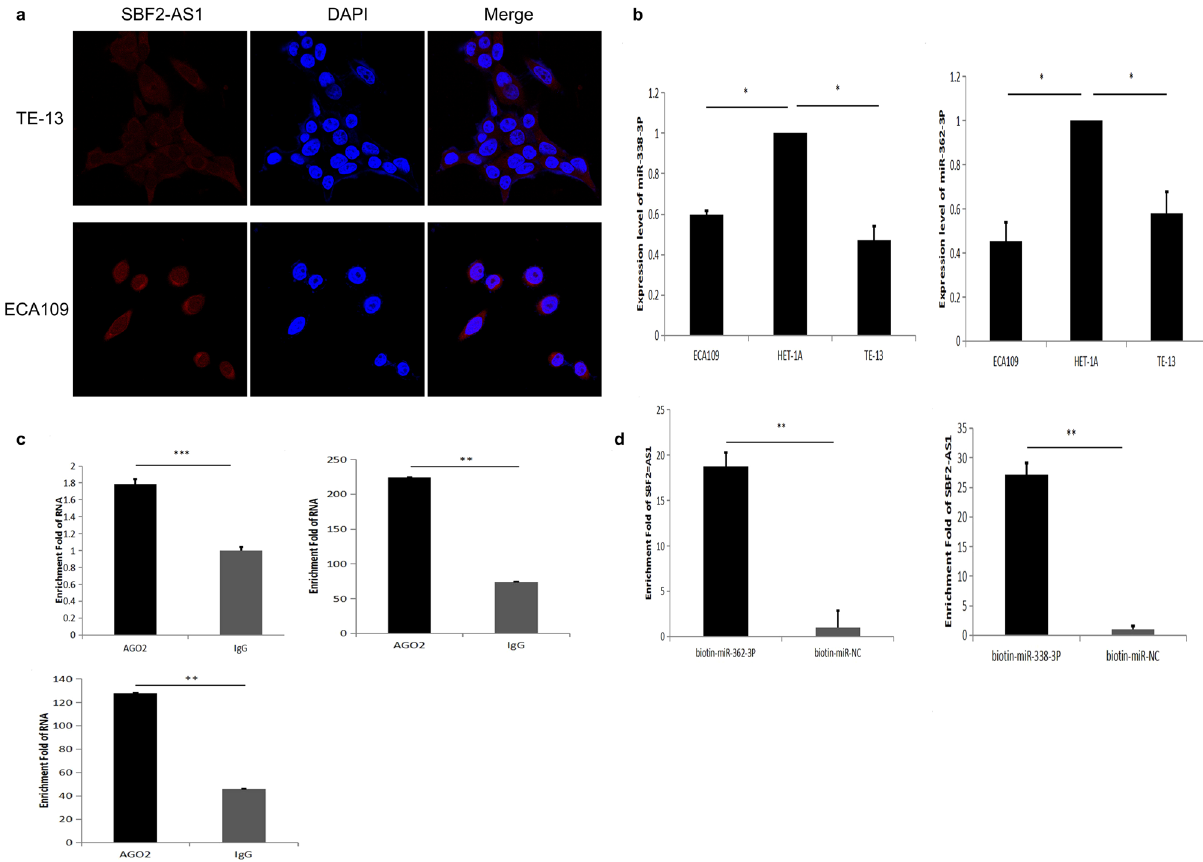
Figure 3. SBF2-AS1 is a sponge RNA for miR-338-3P and miR-362-3P. ( a ) Localization of SBF2-AS1 in oesophageal squamous cell carcinoma. ( b ) The expression of miR-338-3P and miR-362-3P in oesophageal squamous cell carcinoma cells and normal oesophageal cells was detected by RT-PCR. ( c ) A RIP assay using an antibody specifically targeting Ago2 showed that SBF2-AS1 could bind the Ago2 protein in ECA109 cells. ( d ) RNA-pull down assay. Biotin-miR-338-3P, biotin-miR-362-3P and biotin-miR-NC were transiently transfected into ECA109 cells, and enrichment in SBF2-AS1 was determined and compared. Data are shown as the mean ± SEM. *P < 0.05, **P < 0.01, ***P < miR338-3P. To confirm that miR-338-3P and miR-362-3P can bind E2F1, we designed wild-type and mutant E2F1 plasmids. The binding of miR-338-3P and miR-362-3P to E2F1 was confirmed by dual-luciferase reporter gene assays (Fig. 4a). RNA-pulldown experiments were carried out with biotin-labelled miR-338-3P and miR- 362-3P, which revealed that miR-338-3P and miR-362-3P bind more E2F1 than that bound in the control group (Fig. 4b). These findings suggest that E2F1 is a downstream target of miR-338-3P and miR-362-3P. SBF2‑AS1 can upregulate the expression of E2F1 by adsorbing miR‑338‑3P and miR‑362‑3P. To show that SBF2-AS1 upregulates the expression of E2F1 by adsorbing miR-338-3P and miR-362-3P, we designed a series of cross-rescue experiments. Expression of the E2F1 protein in two oesophageal cancer cell lines, ECA109 andTE-13 cells, was detected by Western blot assay. The results showed that the overexpression of SBF2- AS1 promoted the expression of E2F1, while si-SBF2-AS1 inhibited the expression of E2F1. At the same time, the expression levels of Cyclind1 andP21, which are closely related to the cell cycle, was detected. The results showed that SBF2-AS1promoted the expression of Cyclind1 and inhibited the expression of P21 (Fig. 5a). Western blot analysis also proved that miR-338-3P and miR-362-3P could abrogate the upregulated expression of E2F1 and Cyclind1 and downregulated P21 expression caused by SBF2-AS1 (Fig. 5b). Colony-formation, EdU and RTCA rescue assays showed that miR-338-3P and miR-362 could attenuate the effect of SBF2-AS1 on cell proliferation (Fig. 5c,d,f). QRT-PCR rescue experiment showed that miR-338-3P and miR-362-3P decreased the expression level of SBF2-AS1 (Fig. 5e). These findings suggest that SBF2-AS1, acting as a ceRNA, adsorbs miR-338-3P and miR-362-3P and upregulates E2F1 to promote the proliferation of oesophageal cancer cells. SBF2‑AS1ASO could inhibit the proliferation of oesophageal cancer cells in vivo. To inves- tigate whether SBF2-AS1 interference could inhibit the proliferation of ESCC in vivo, we designed SBF2-AS1 ASO, a siRNA with a therapeutic effect. We used male SPF-grade Balb/C nude mice to carry out a subcutaneous tumour-bearing experiment. The mice were divided into the ASONC group and ASO group. The results showed